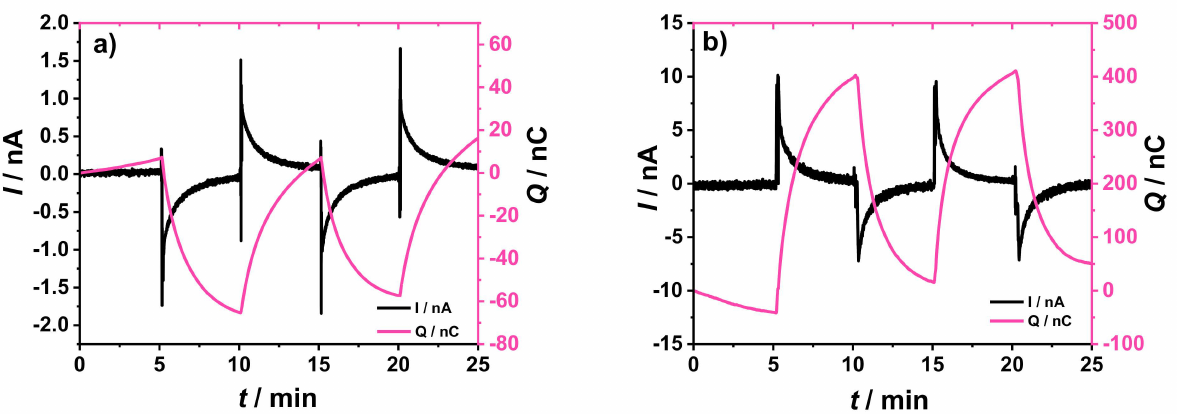
Figure 4. Chronoamperometric and chronocoulometric response collected using ( a ) the original setup (WE: GC/2 mC PEDOT:PSS/50 µ L K + -ISM, RE: Ag/AgCl/3 M KCl/1 M LiOAc, CE: GC rod), and ( b ) the novel experimental setup (WE: GC/10 mC PEDOT:PSS/25 µ L DM, RE: GC/2 mC PE- DOT:PSS/50 µ L K + -ISM, CE: GC rod) for the coulometric signal transduction. The addition/dilution steps correspond to a 5% increase/decrease of K + concentration in a starting solution of 10 − 3 M KCl + 10 − 1 M NaCl as